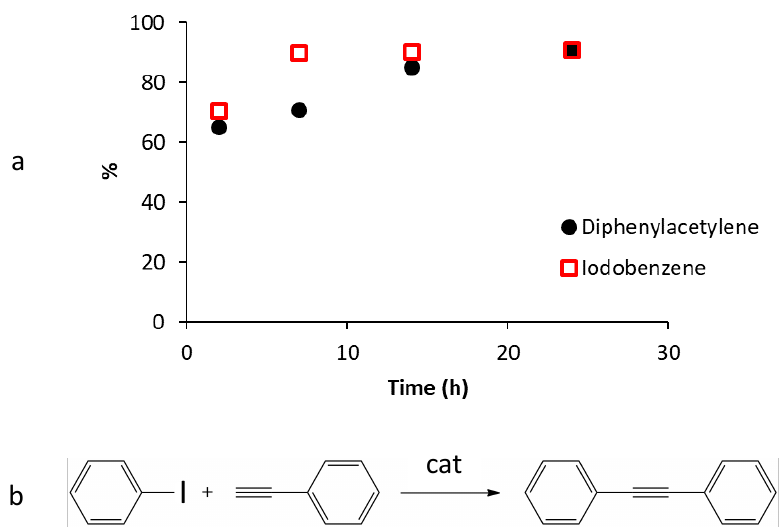
Figure 11. ( a ) Amounts of the formed diphenylacetylene, DAC, (referred to the theoretical 100% in mmol) and of the consumed iodobenzene, IB, (referred to initial 100% in mol) as a time function in the course of the reaction of iodobenzene with phenylacetylene. ( b ) The studied Sonogashira cross-coupling reaction.